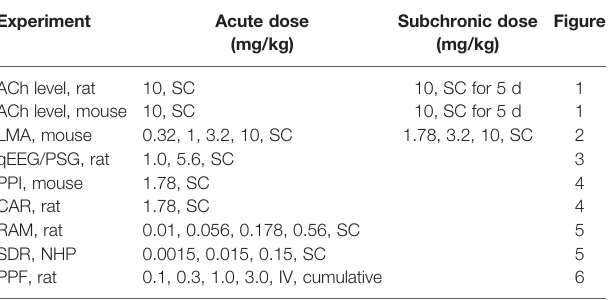
TABLE 1 | Summary of experimental paradigms and doses of PF-6142 used.